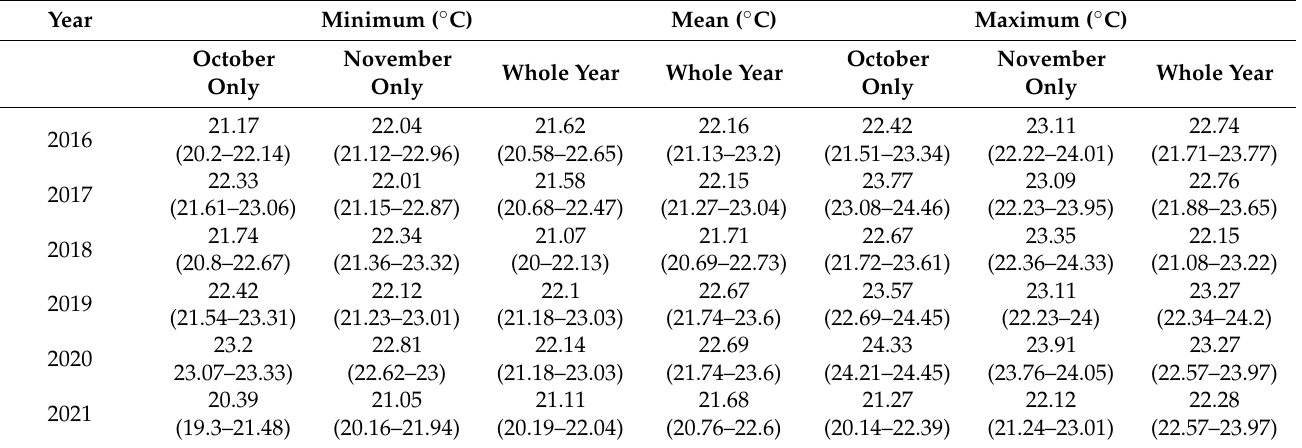
Table 2. Minimum, mean and maximum temperature ( ◦ C) in State of Rio de Janeiro, 2016–2021. Monthly temperature data for this period for weather stations in the state were obtained from the Brazilian National Institute of Meteorology [11] (see Methods). For each station, we determined the annual minimum, mean and maximum temperatures, as well as the October and November minimum and maximum temperatures. For each of these variables, we report the mean and standard error of the observations from all of the